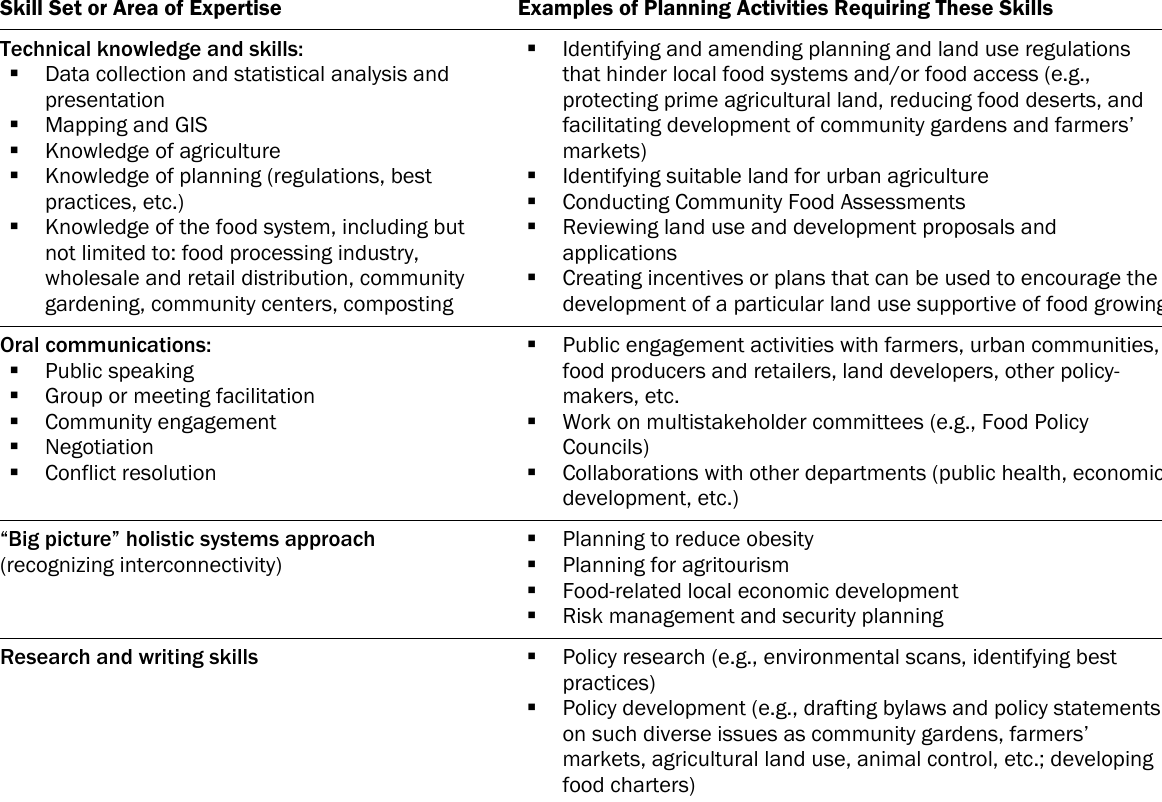
Table 3. Skills and Expertise Needed for Competent Food System Planning Skill Set or Area of